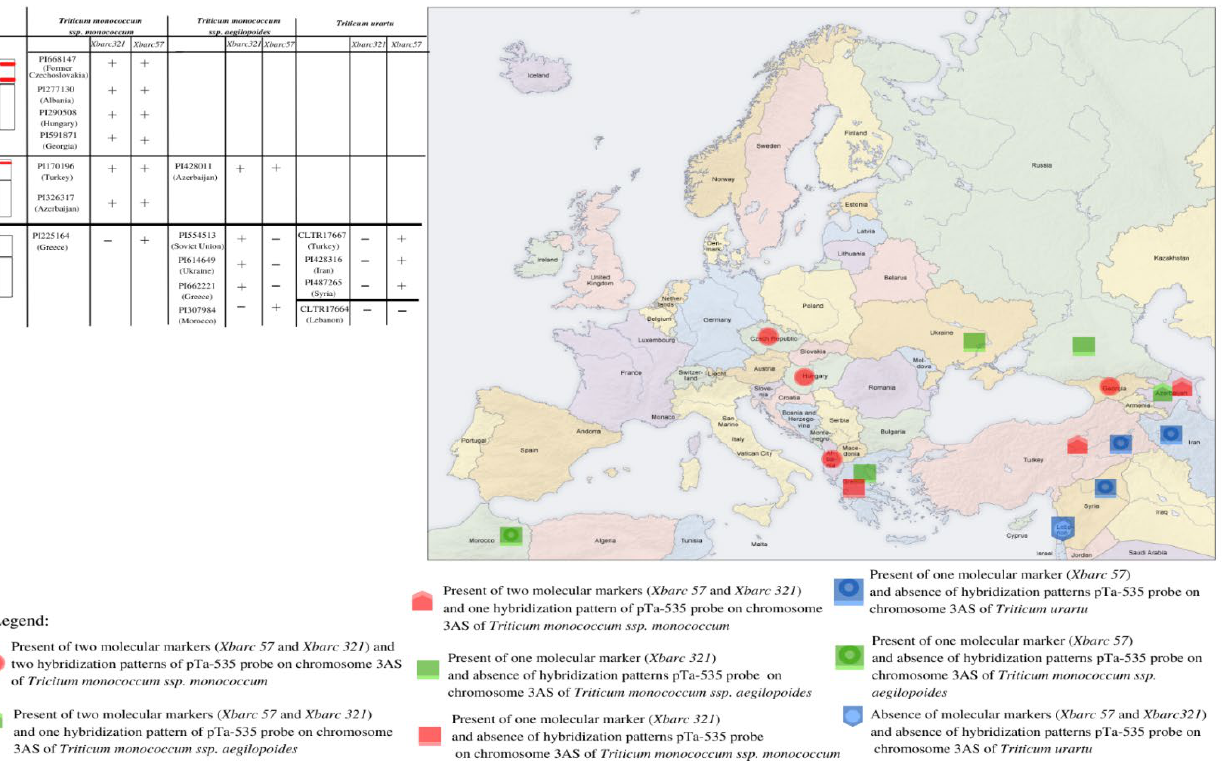
Figure 3. Geographical distribution of the studied accessions divided into three groups according pTa-535 signal location, as well as molecular markers, the presence of a particular amplification product.